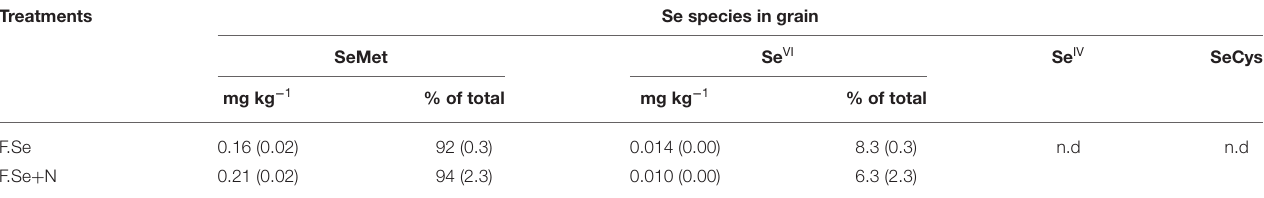
TABLE 4 | The distribution of the extracted Se species in wheat grain expressed as mean concentration or as % of total extracted grain Se (SE in brackets, n = 4). Treatments